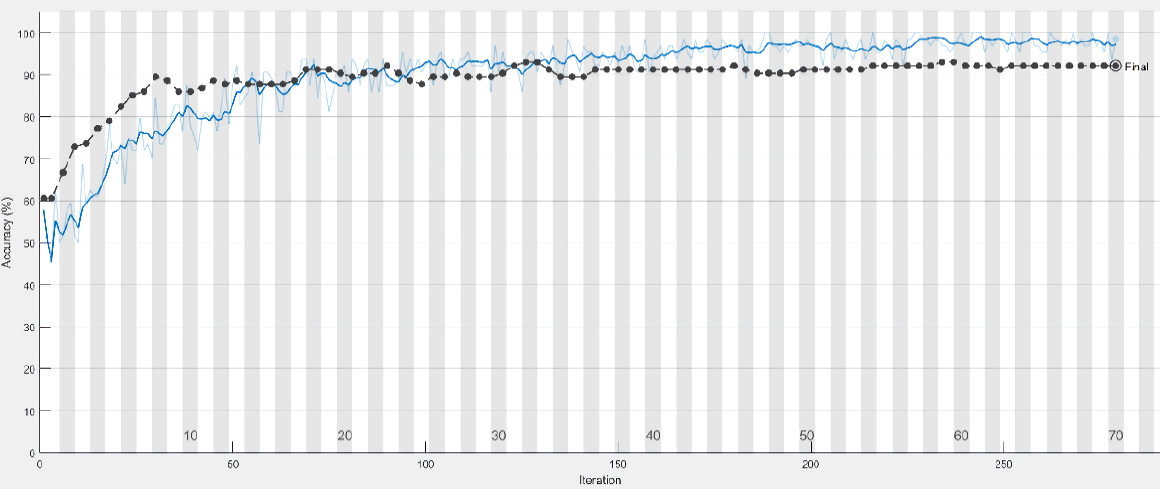
Figure 9. The training process of the model with the accuracy in the test set (black line) and the training set (blue line). Table 7. Verbose.